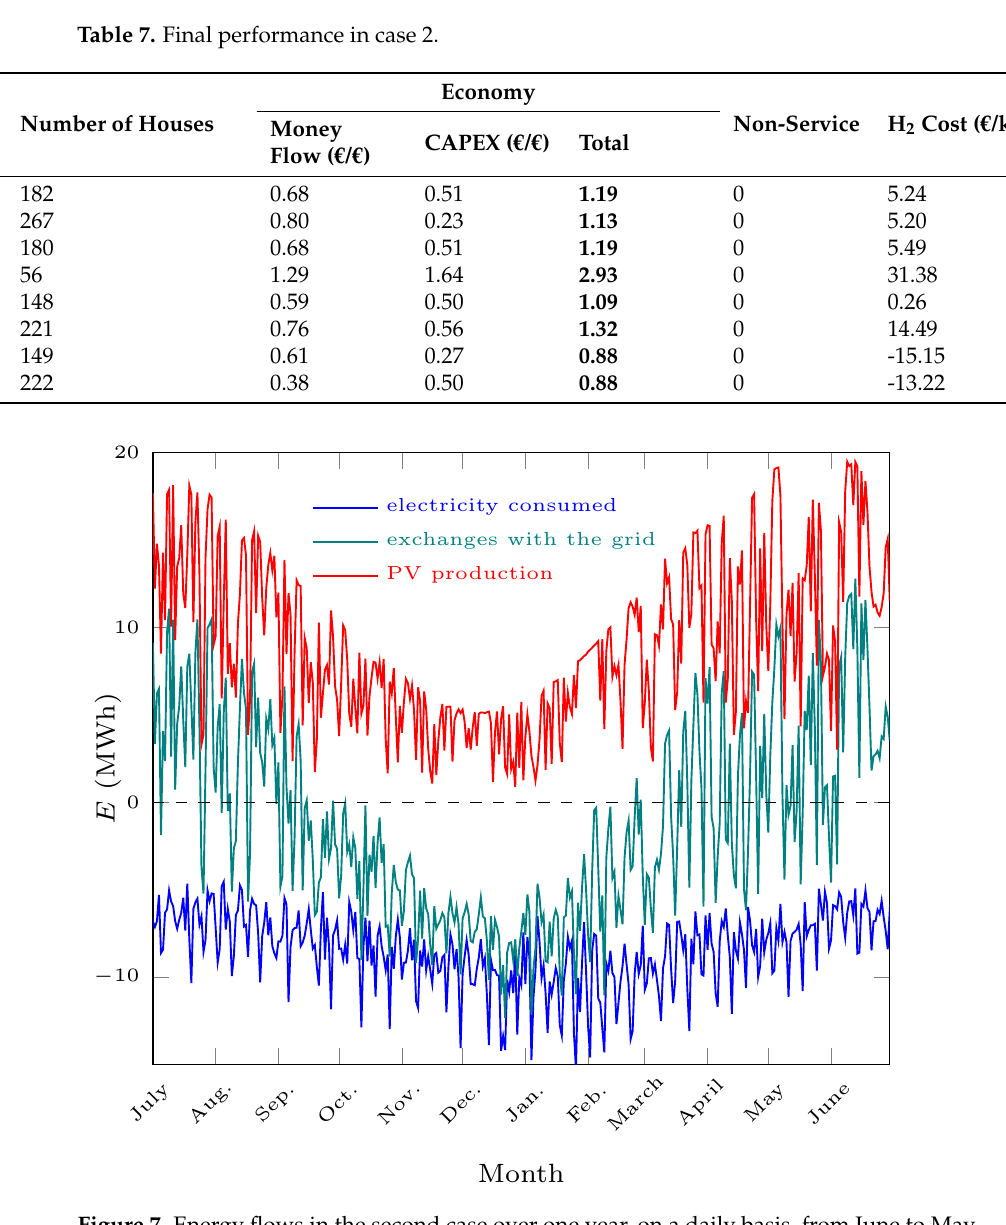
Figure 7. Energy flows in the second case over one year, on a daily basis, from June to